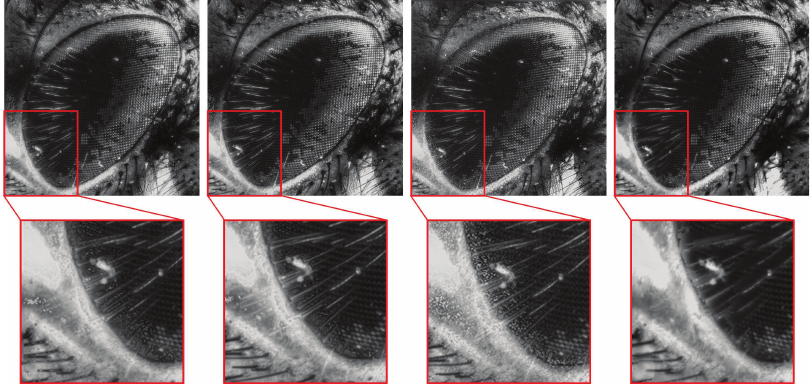
Figure 13. Fused images using: ML (first column), GLV (second column), TEN (third column) and OCA (last